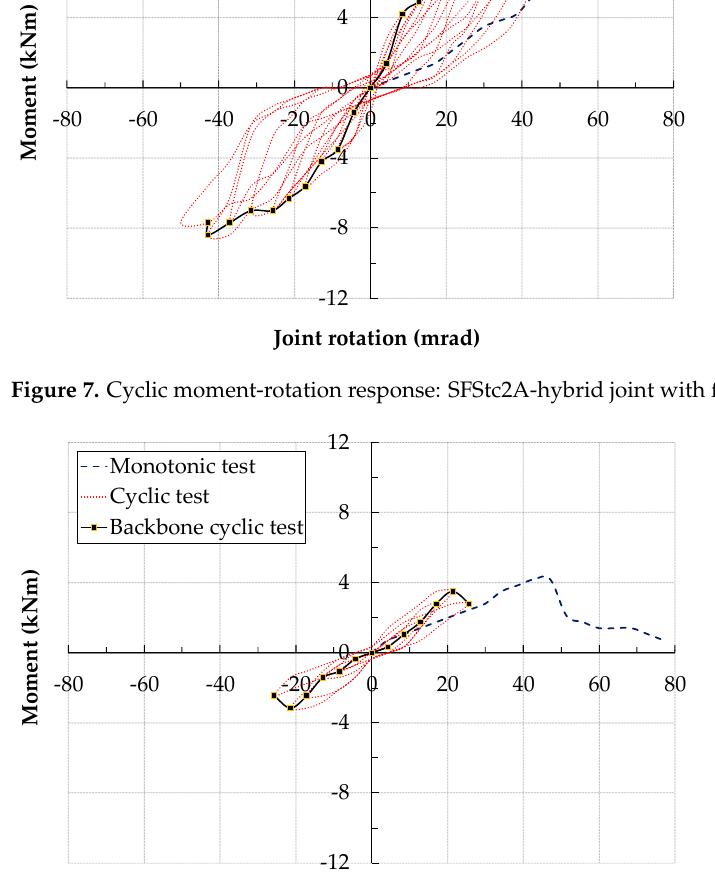
Figure 8. Cyclic moment-rotation response: SFFc2-bolted joint with double web and flange FRP cleats.